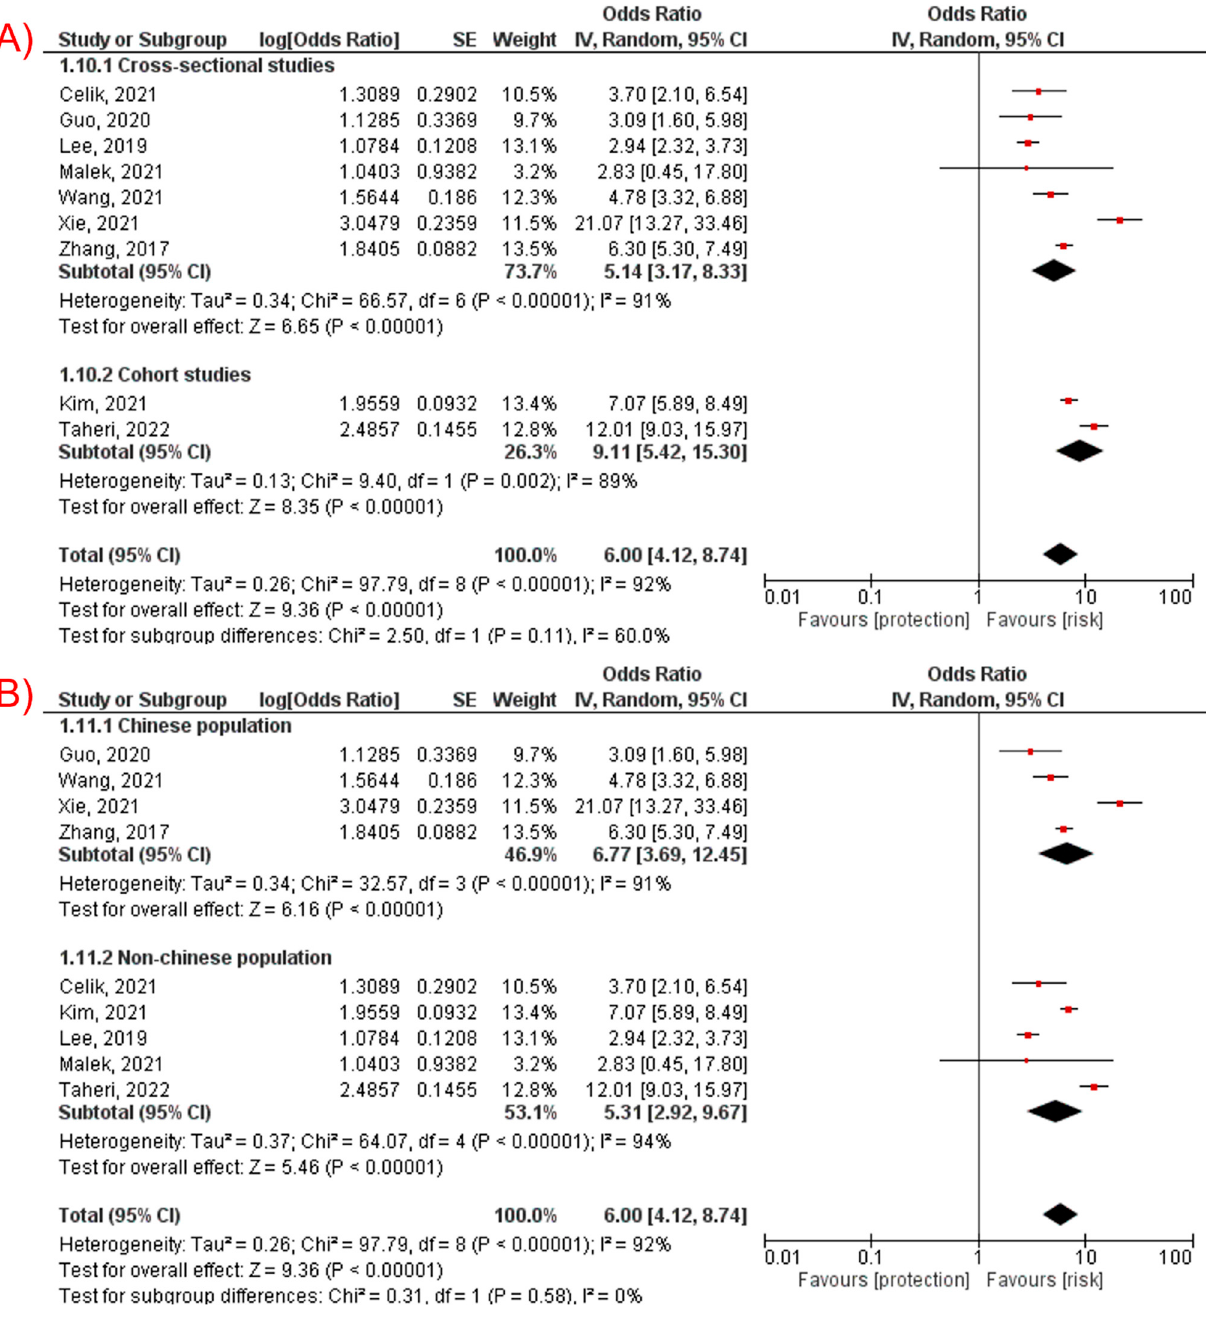
Figure 3. Subgroup analyses for the association between TyG index and NAFLD: ( A ) subgroup analysis according to the study design [10,11,14,15,21,23,26,28,29] and ( B ) subgroup analysis according to the ethnicity of the population [10,15,21,23,26].